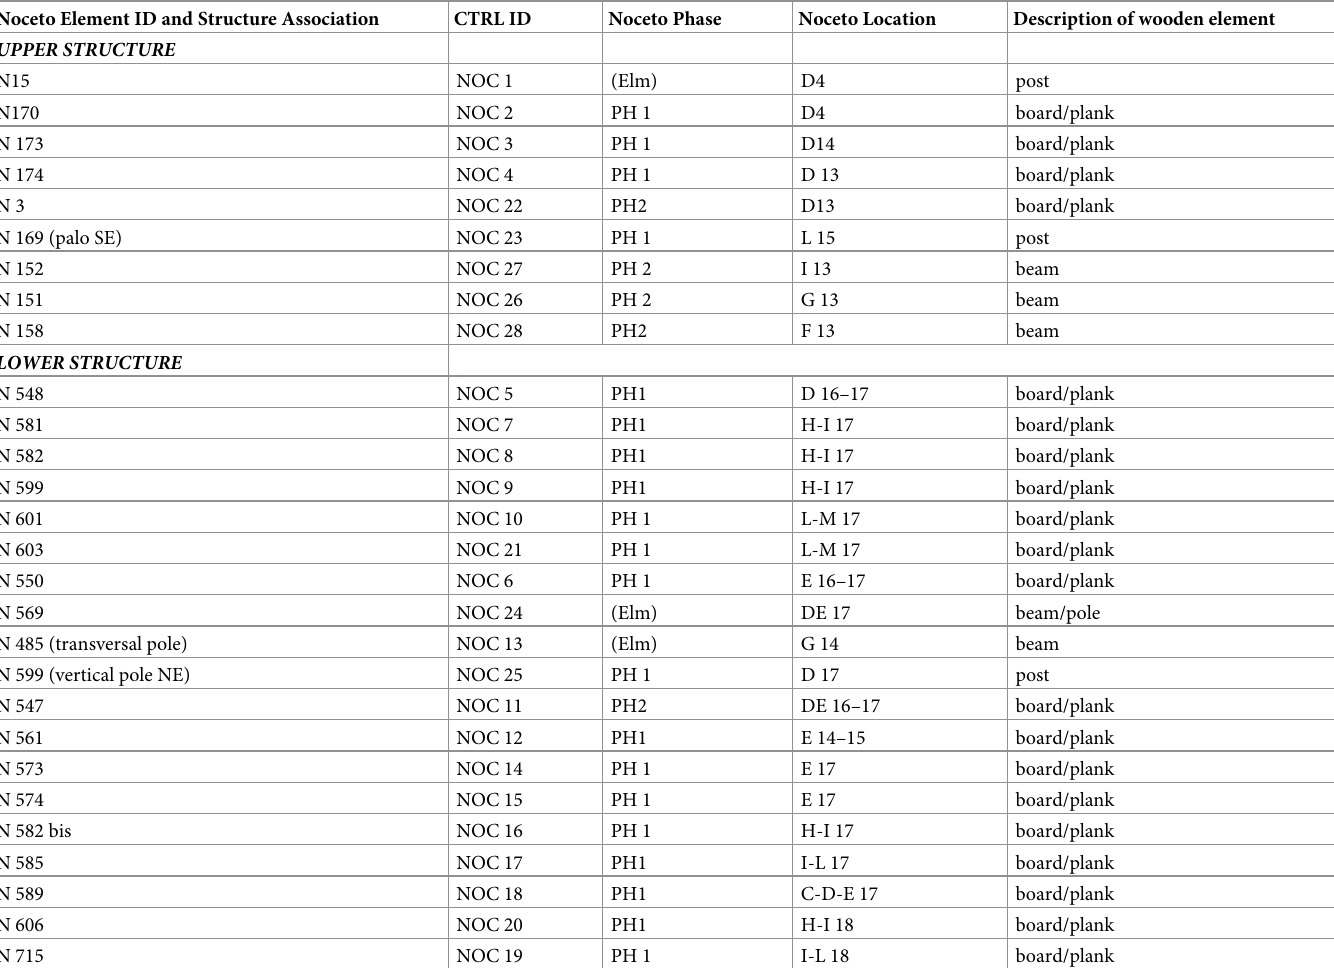
Table 1. Find locations of the samples from the two superposed Noceto tanks and the relation with the two phases identified by the dendrochronological